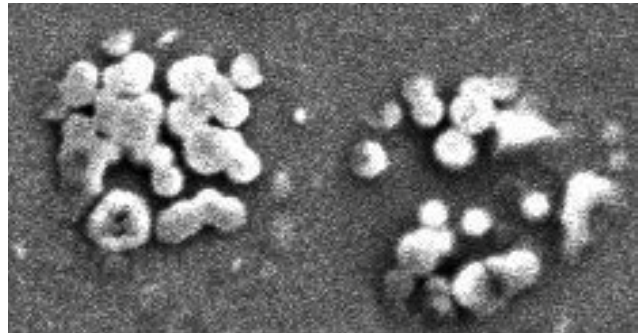
Figure 14. SEM image of aggregates of influenza B antigen (virus) on the graphene surface of a chip from Group 1. Field of view is 2 × 1 μ m 2 .